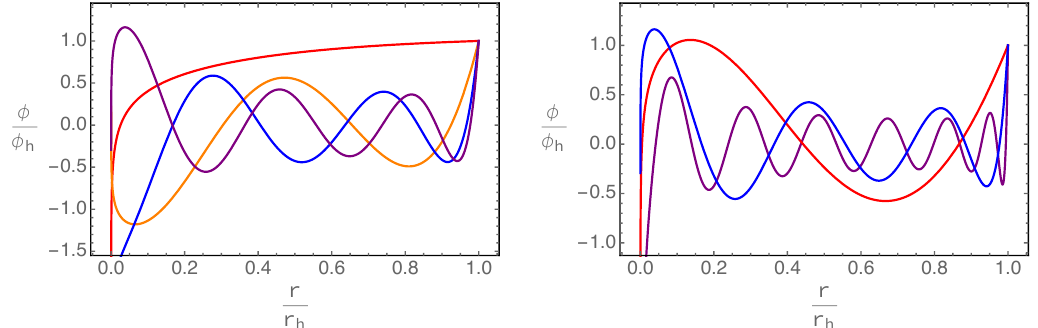
Figure 2 . The plots of φ/φ h along radial direction in the oscillation region at fixed T/b = 0 . 02 (left) while M/b = 0 . 1 (purple), 0 . 4 (blue), 0 . 6 (orange), 0 . 74 (red), as well as at fixed M/b = 0 . 1 (right) while T/b = 0 . 05 (red), 0 . 02 (blue), 0 . 01 (purple). Here φ